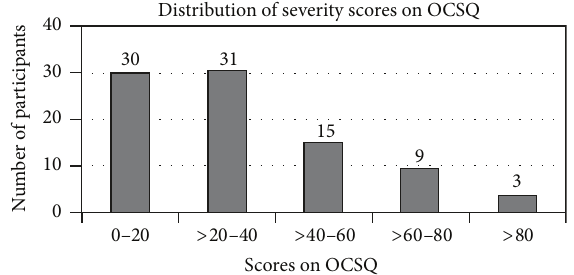
Figure 4: The number of self-identified participants that scored within each severity group on the Otago Condition Specific Ques- tionnaire. Higher scores indicate worse quality of